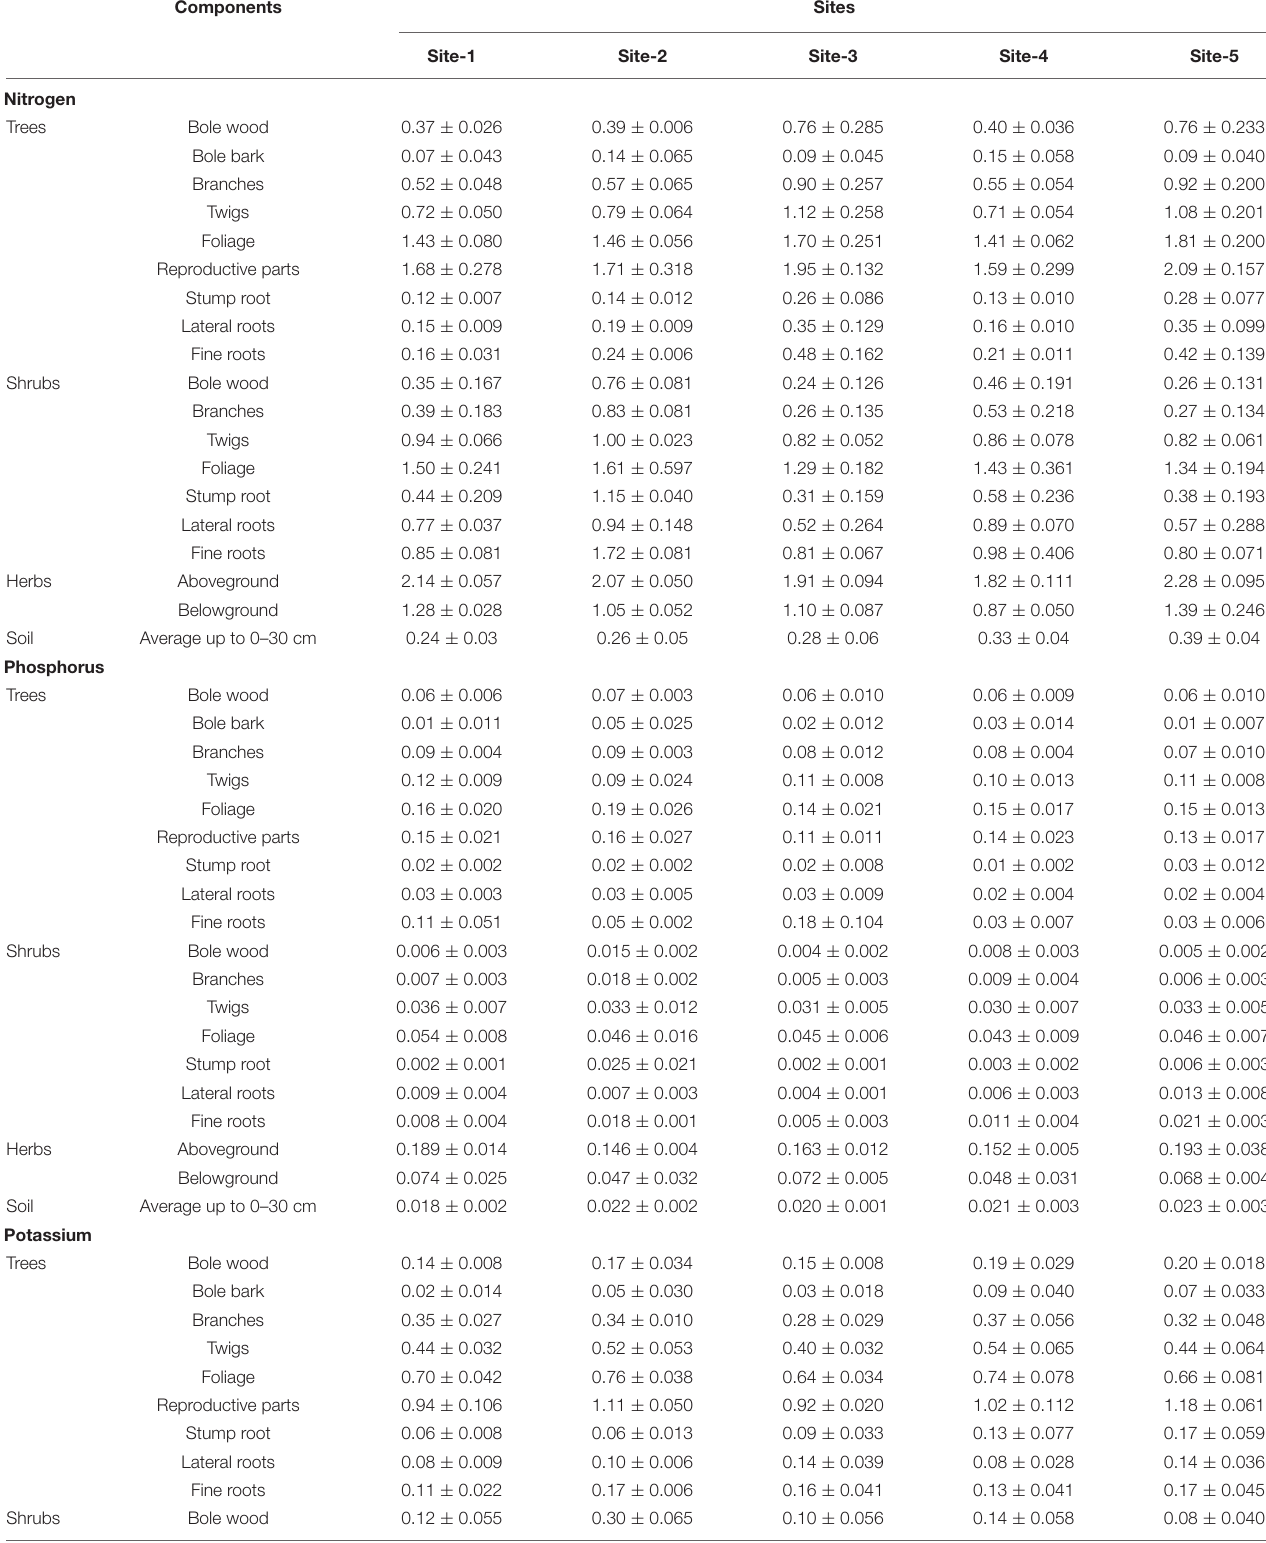
TABLE 1 | Mean ( ± SE) concentration (%) of nitrogen, phosphorus, and potassium in different components of tree layer, shrub layer, herb layer, and soil across the selected